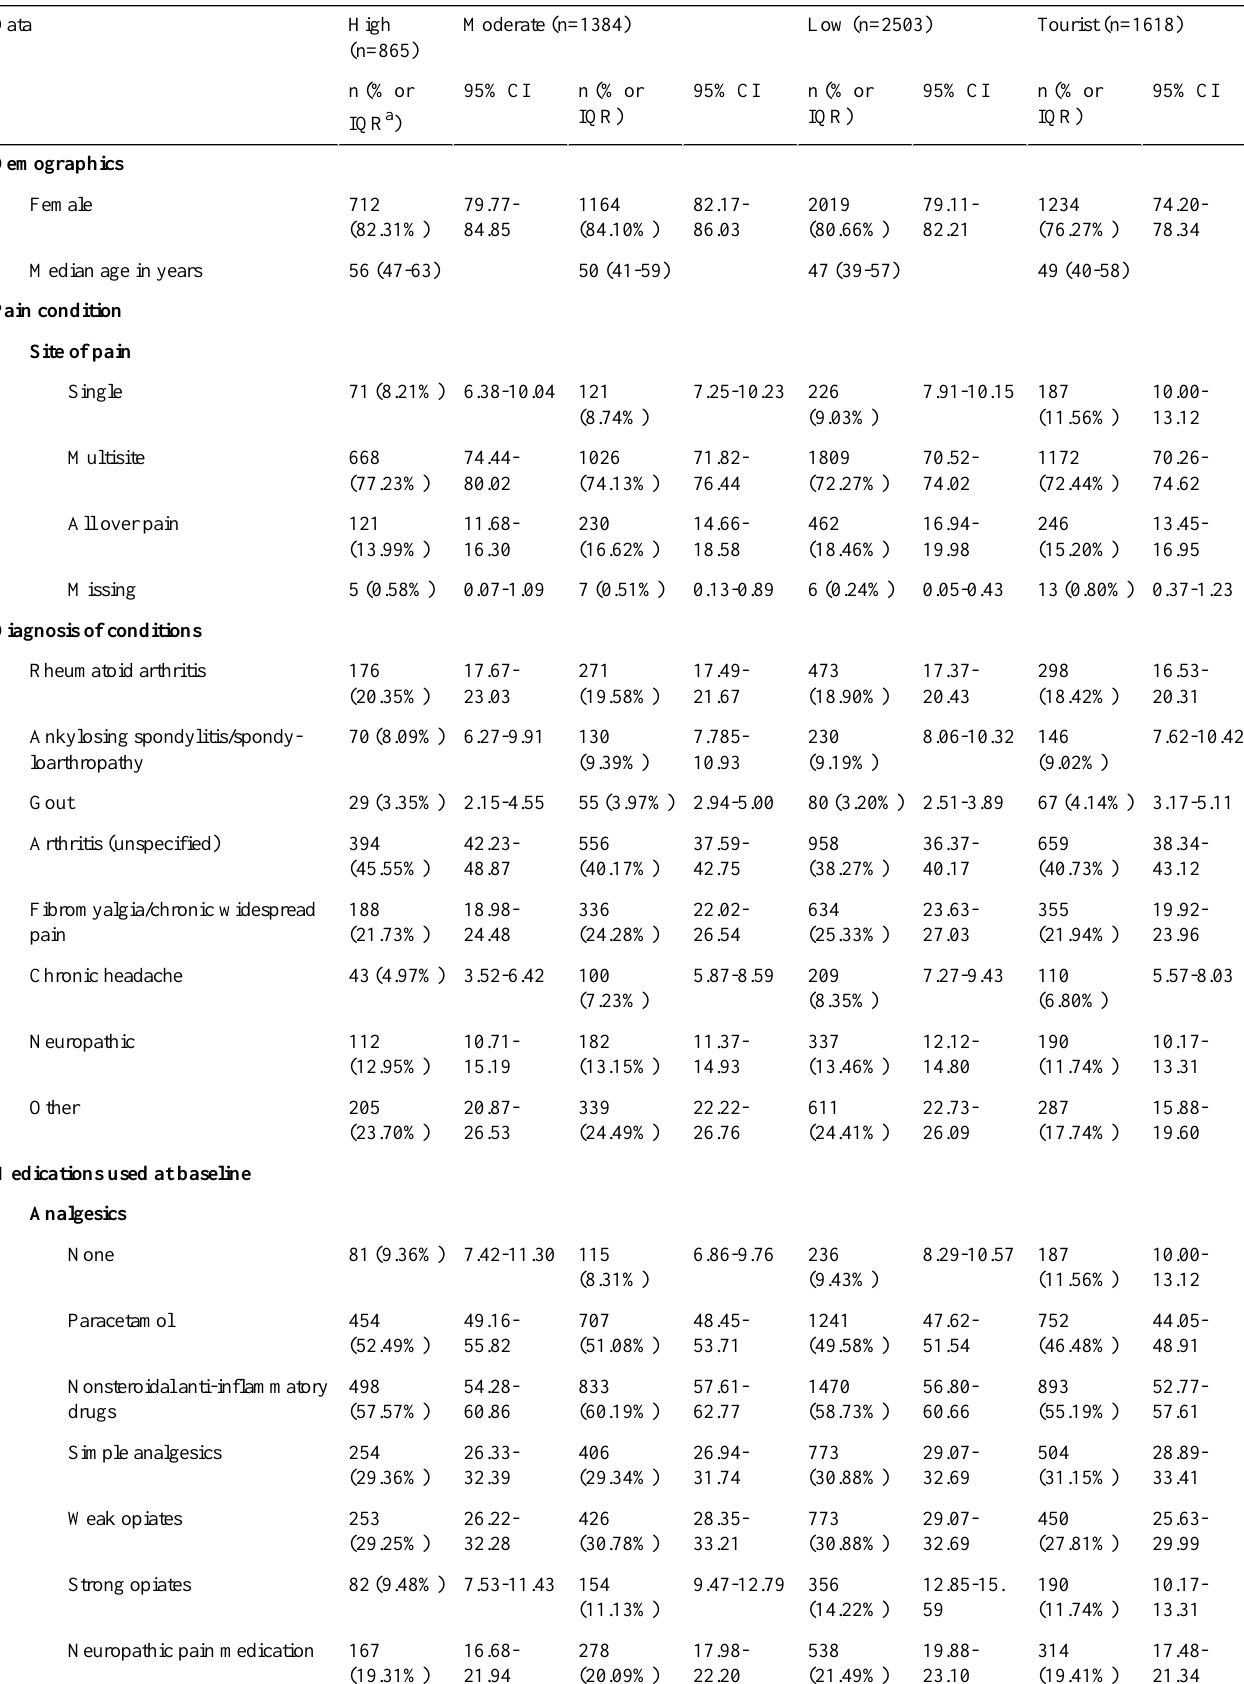
Table 4. Characteristics of the 6370 Cloudy with a Chance of Pain participants clustered by levels of